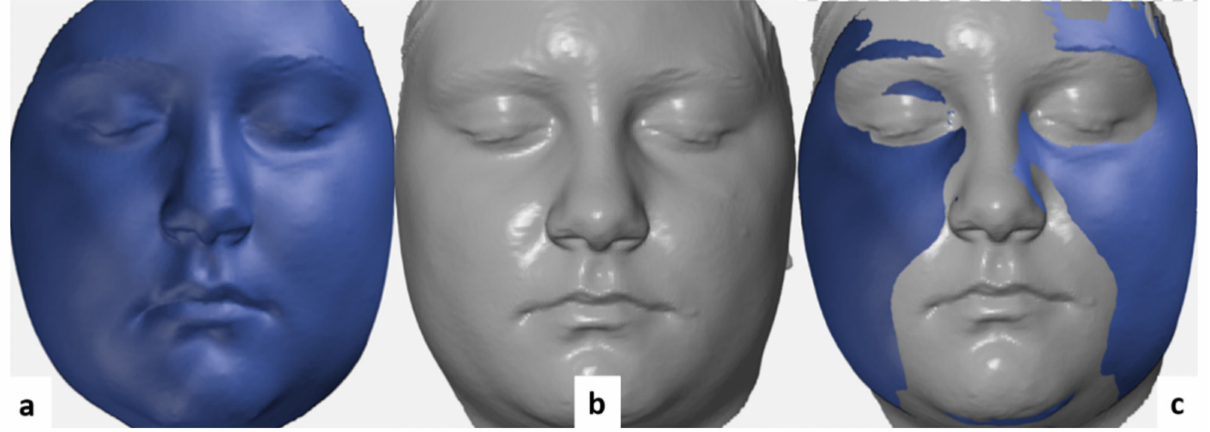
Figure 5. The best-fit method used in our study. ( a ) T 0 mesh. ( b ) T 1 mesh. ( c ) The final mesh